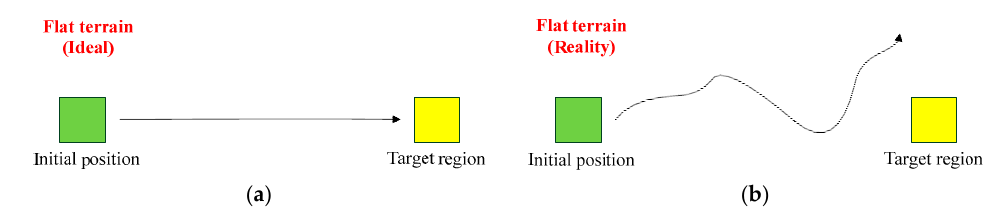
14 of 23 Figure 14. Trajectories and footprints with turning directions: ( a ) CoM trajectories; ( b ) left ankle trajectories; ( c ) right ankle trajectories; ( d ) footprint of the humanoid robot. 5. Learning the Straightforward Gait Pattern In this paper, a flat terrain was adopted for the humanoid robot to learn the straightforward gait pattern. Most gait patterns are designed assuming an ideal situation, where the mechanism and motors are working well. However, the long-term operation of the humanoid robot may result in mechanism error and motor backlash. Moreover, the real environment also cause the humanoid robot to exhibit some unexpected behaviors. As shown in Figure 15, the target region (yellow area)